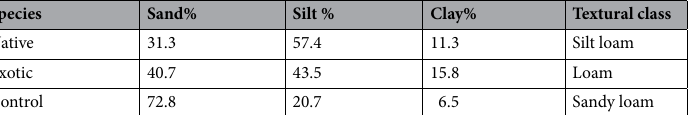
Table 1. Soil textural composition percentage and soil textural class observed under different Tamarix species and the control (open-land).